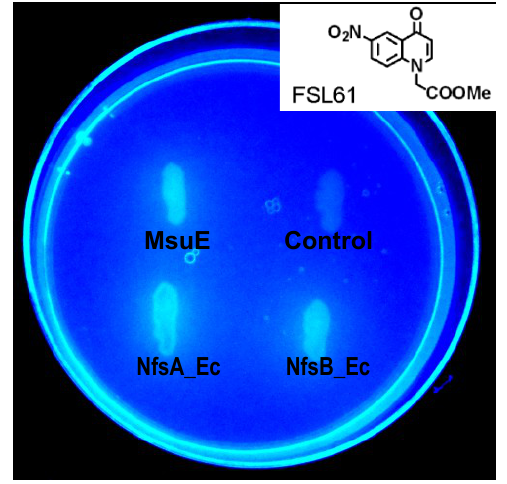
Figure 1. Nitroreductase-dependent activation of the fluorogenic probe FSL 61. E. coli SOS-R2 strains over-expressing NfsA_Ec, NfsB_Ec or MsuE as indicated, or